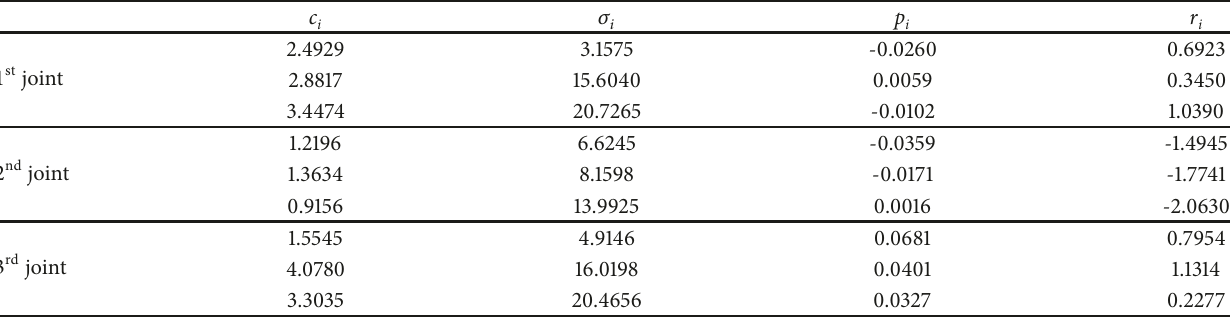
Table 1: Parameters of the ANFIS after training.